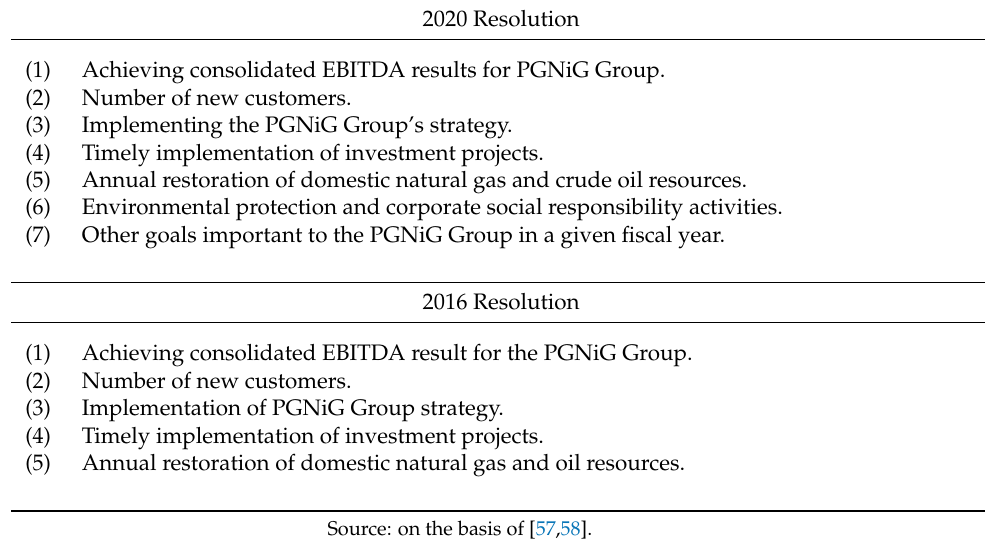
Table 6. Management goals of Polskie G ó rnictwo Naftowe i Gazownictwo